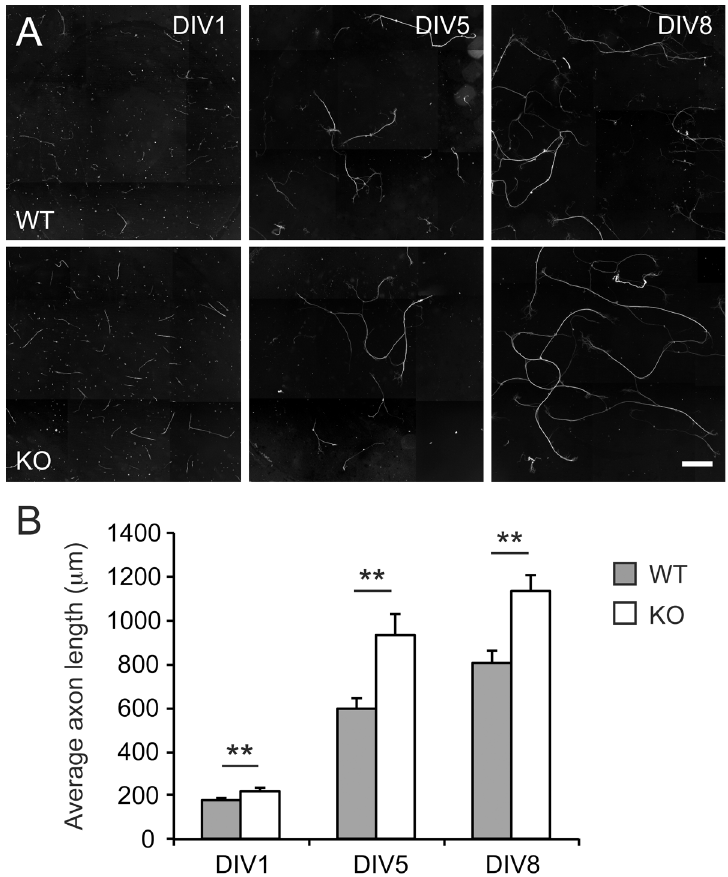
Fig 2. Nfil3 deletion enhances axon growth of DRG neurons in culture. (a) Example images of cultured embryonic DRG neurons from wildtype mice (top panels) and Nfil3 KO mice (bottom panels) at 1, 5 and 8 days in vitro (DIV; scale bar: 500 μ m). (b) Quantification of axon lengths showed that the average axon length of Nfil3 KO neurons was significantly higher compared to wildtype neurons at DIV1 (222 ± 10 μ m vs. 178 ± 9 μ m; n = 69/71), at DIV5 (931 ± 101 μ m vs. 595 ± 48 μ m; n = 26/31) and at DIV8 (1134 ± 77 μ m vs. 806 ± 57 μ m; n = 32/34) (Student ’ s t test; mean ± SEM; ** p < 0.01). open field and rotarod tests. The total distance moved in the open field task was unchanged in = -0.27, p = 0.98, Fig 3a), nor did we observe a difference in Nfil3 KO mice (n = 12, t (22) = 1.02, p = 0.32, Fig 3b), indicating that general move- rotarod performance (n = 12, F (1,22) ment and motor skills are unaltered in Nfil3 KO mice. Next, we applied sciatic nerve transsec-